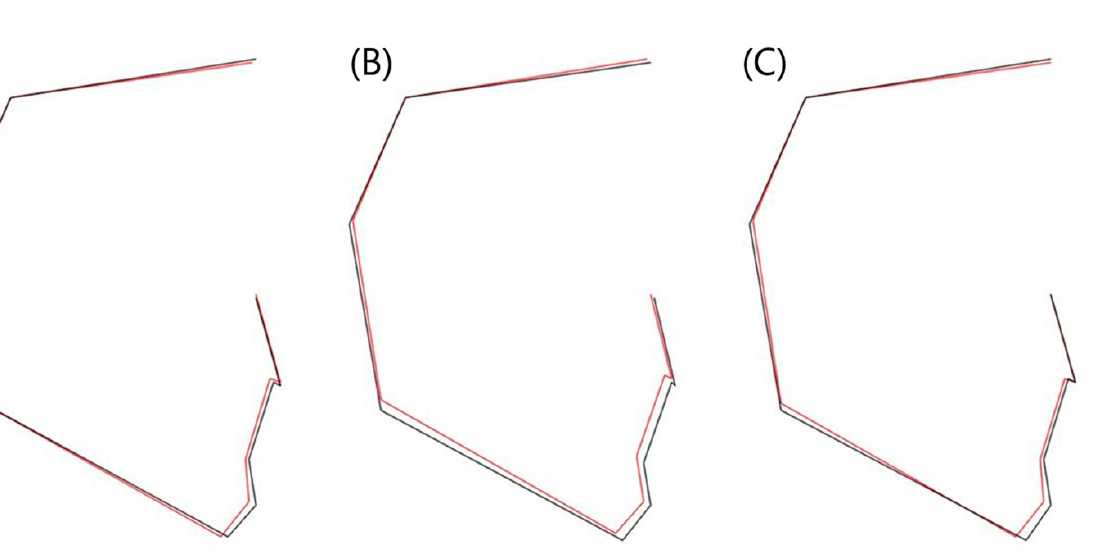
Figure 5. Comparison of skeletal profilograms between the high group (black line) and the low group (red line); ( A ) TAP, anterior tongue pressure. ( B ) TPP, posterior tongue pressure. ( C ) LP, lip pressure.